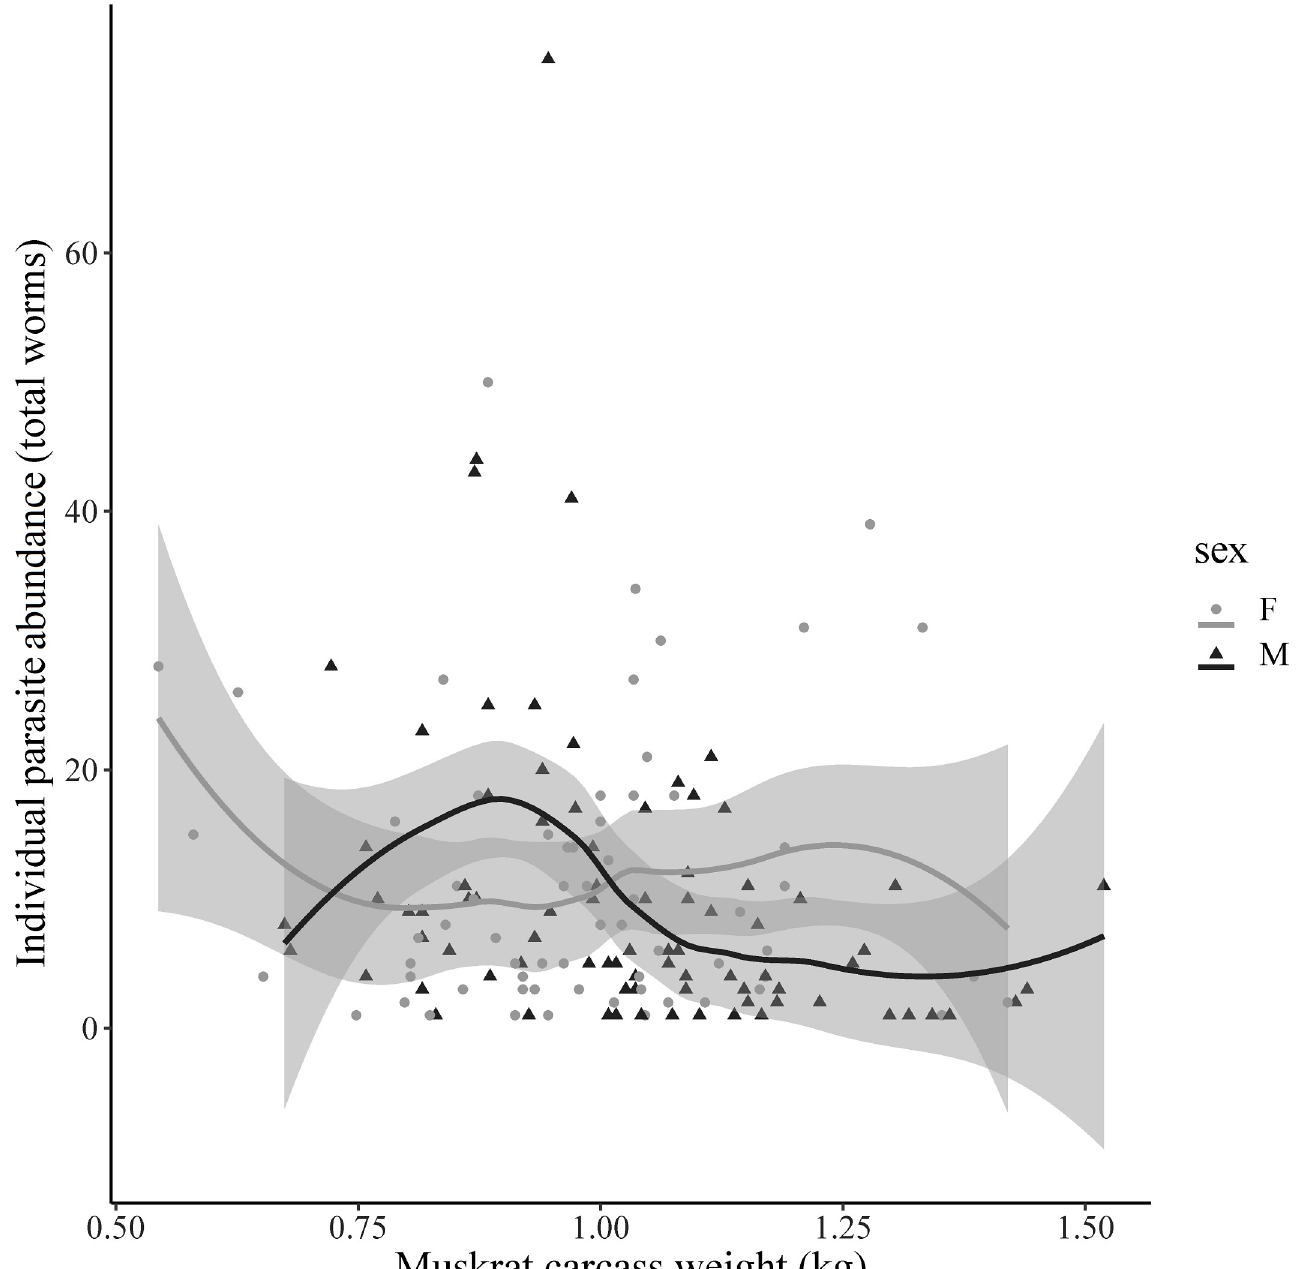
Fig 5. Loess regression of carcass weight (kg) to parasite abundance found in individual muskrats ( Ondatra zibethicus ) for males (M) and females (F) in Pennsylvania, USA in 2019. https://doi.org/10.1371/journal.pone.0260987.g005 the liver consistent with Tyzzer’s disease. Using the modified agglutination assay, 143/380 (38%) of tissue exudate samples were positive for antibodies to T . gondii (Ab titer > 1:25) (Fig 6). Of these 143 muskrats, heart samples from 52 (36%) were positive for apicomplexans by PCR. However, sequencing of a random subset of these amplicons (n = 28), indicated that only one was positive for T . gondii . One of the remaining muskrats was positive for a